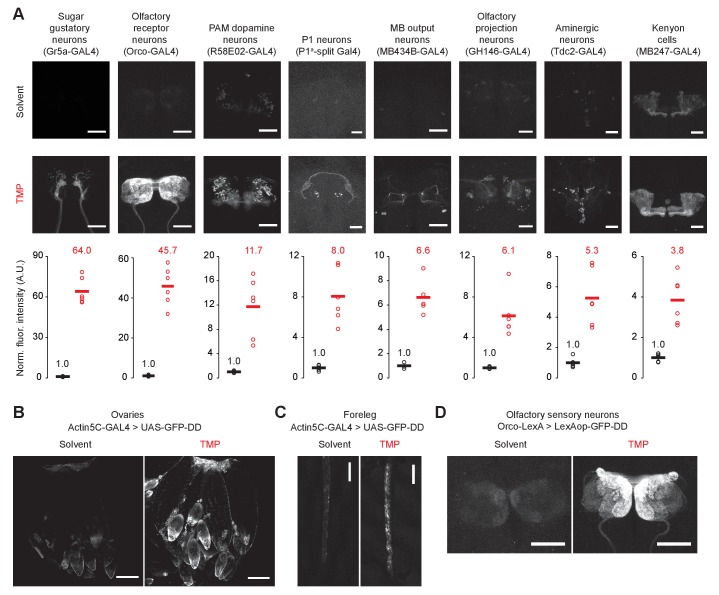
TMP-dependent GFP expression in different tissues.(A) TMP-dependent GFP expression in different cell types in the adult brain. Fluorescence intensity has been normalized to the mean fluorescence intensity from the brains of flies fed with the solvent. Flies were fed with solvent or TMP-containing food from embryo stage to five days post-eclosion. Differences in GFP expression between solvent and TMP-fed flies are significant for all cell-types shown (n = 4–6, p<0.003, t > 5.3, unpaired t-test, two-tailed, for all cell types). (B, C) TMP-dependent GFP expression in ovaries (B) and the foreleg (C). (D) TMP-dependent GFP expression in olfactory sensory neurons driven by the LexA/LexAop system. Scale bar = 50 μm (A, D), 100 μm (B), 150 μm (C).10.7554/eLife.30327.007Figure 1—figure supplement 3—source data 1.TMP-dependent GFP expression in different tissues.